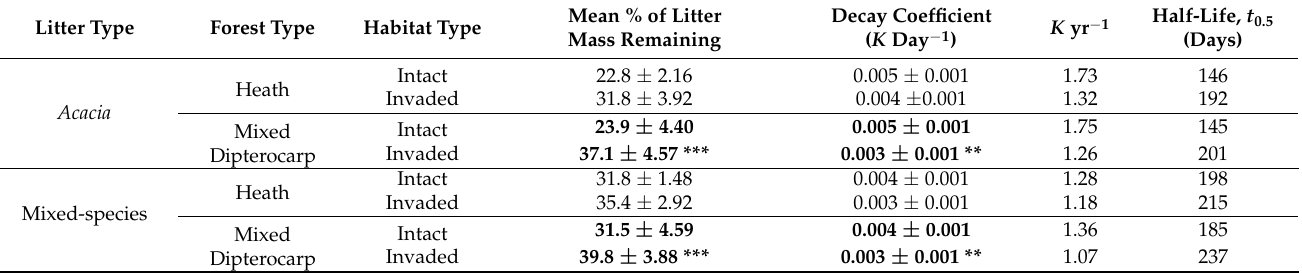
Table 4. Mean percentages (%) of litter mass remaining, annual litter decomposition rates (decay coefficients or K day − 1 and yr − 1 ), and half-lives ( t 0.5 in days) at heath forest (intact and Acacia - invaded) and mixed dipterocarp forest (intact and Acacia -invaded) at the end of litter decomposition experiment using two litter types ( Acacia mangium litter and mixed-species litter).